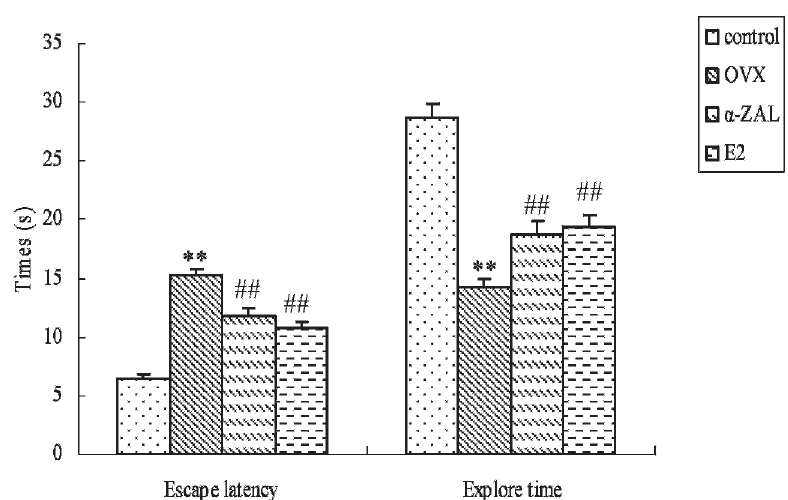
Figure 1 - The effects of a -ZAL treatment on escape latency and explore time during the Morris water maze in OVX-induced, memory- deficient mice. The training began on the 52 nd day after a -ZAL or E2 administration. Four training trials each day were conducted for four consecutive days. The escape latency and explore time from the Morris water maze are shown for the probe test session (the results from the trial at the 56 th ). ** p , 0.01 vs. control group; ## p , 0.01 vs. OVX group (n=10 in each